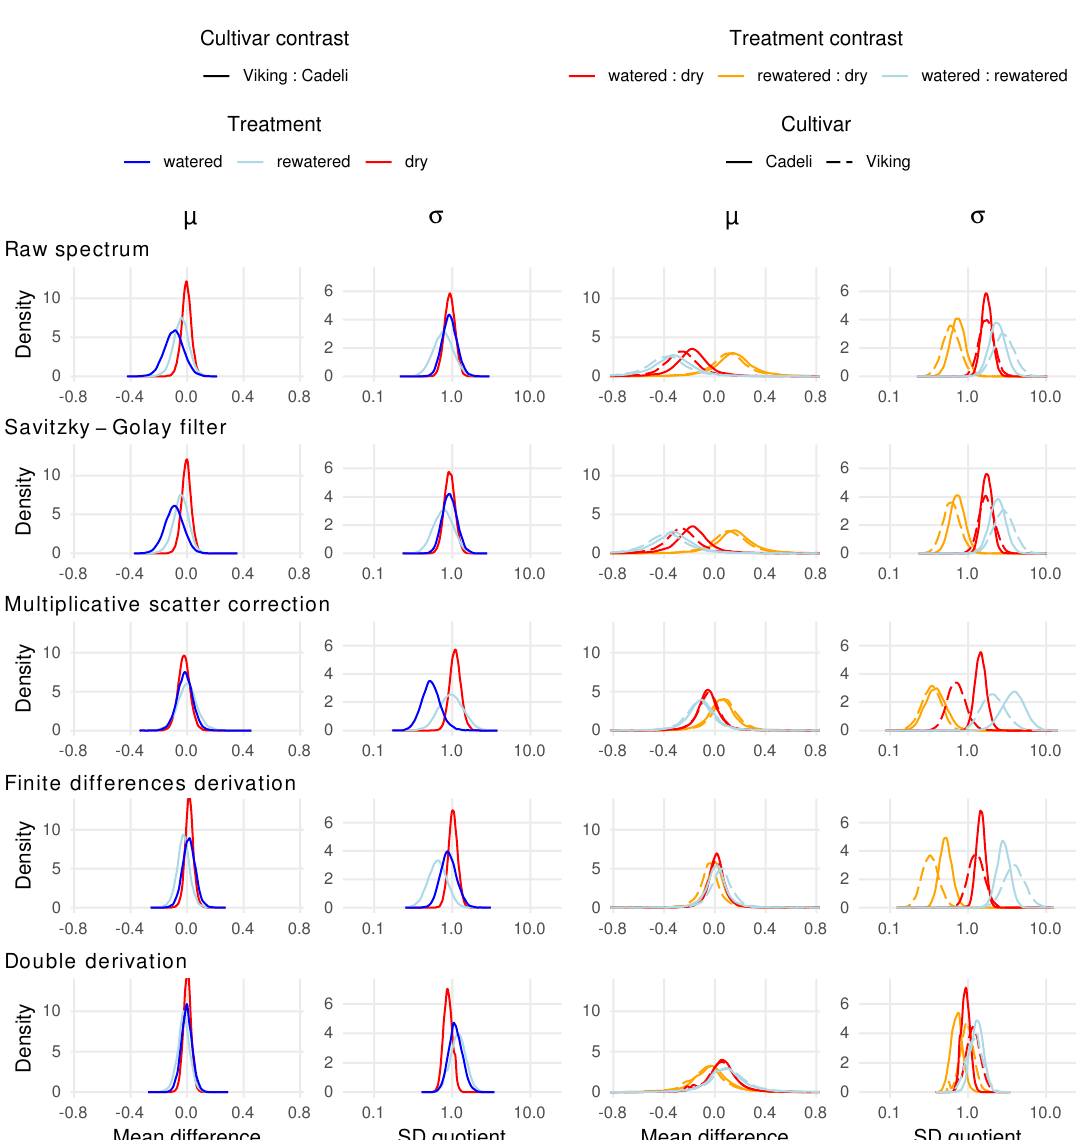
Figure 8. Posterior distributions of the mean ( µ ) and standard deviation ( σ ) differences between experimental factors for first principal component loading values according to spectra pre-processing. The mean and standard deviation differences are assumed to be additive and multiplicative, respectively. The left-hand and right-hand side subplot columns depict comparisons between the cultivars and watering regimes, respectively. The latter are on a semi-logarithmic